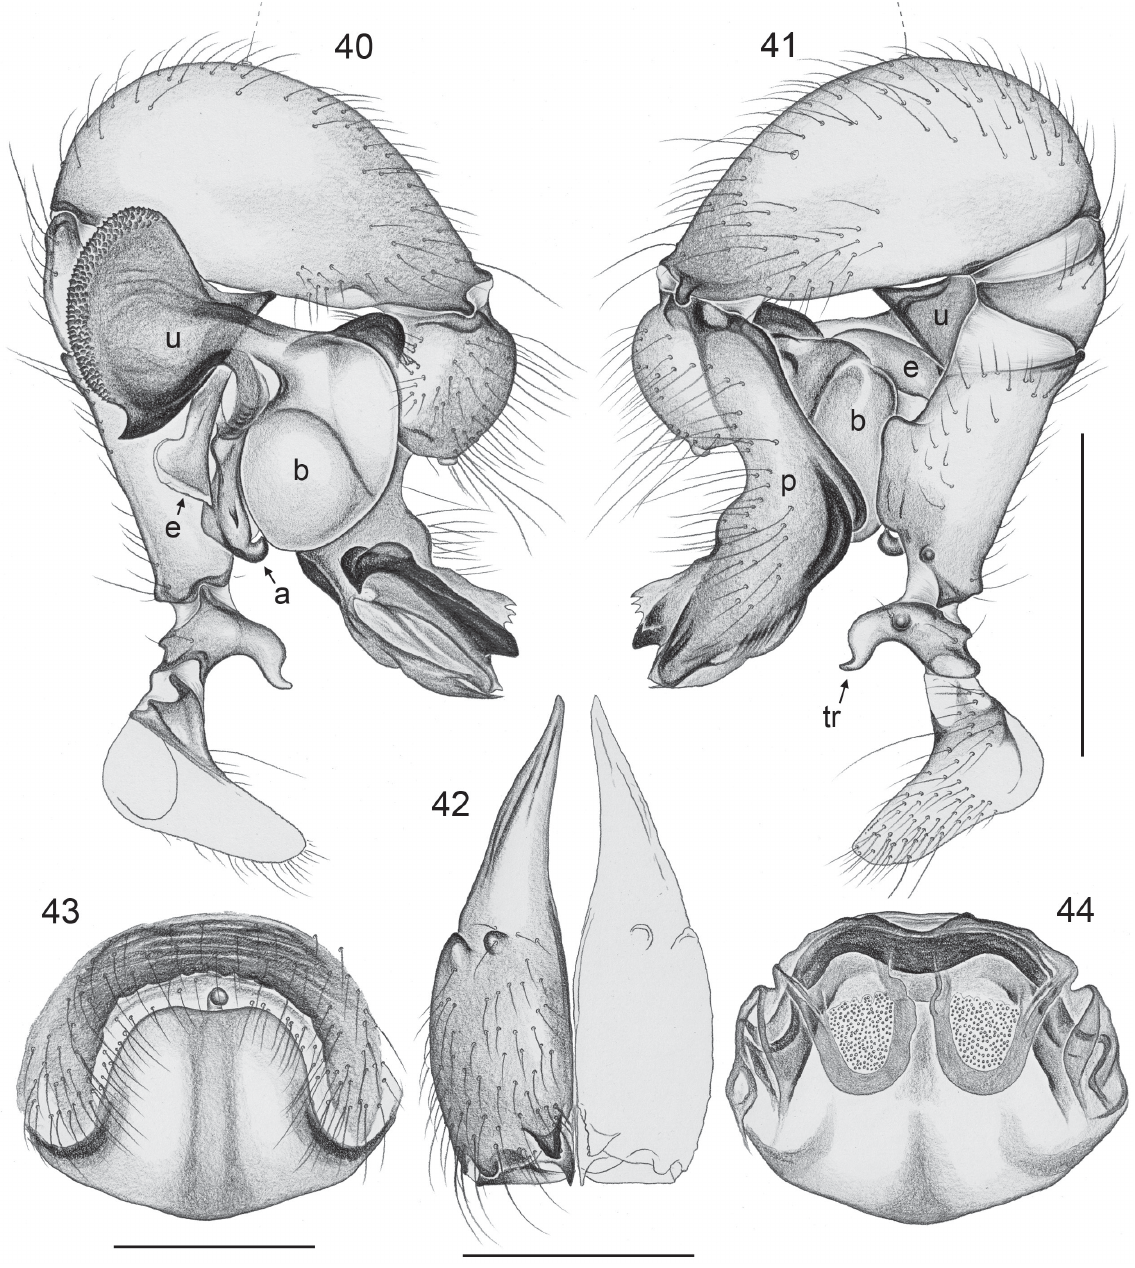
ventral process; tibia large, with small but distinct ventral cavity (for proximal bulbal sclerite); procursus complex distally, with distinctive prolateral sclerite and membranous structures; bulb with large rounded uncus with pointed process, weakly sclerotized and distally widening embolus, appendix with small prolateral spine, distally curved towards retrolateral. l egs . Without spines or curved hairs; few vertical hairs; retrolateral trichobothrium on tibia 1 at 3.5%; prolateral trichobothrium absent on tibia 1, present on other tibiae; tarsus 1 with >30 pseudosegments, only distally about 20 fairly distinct.